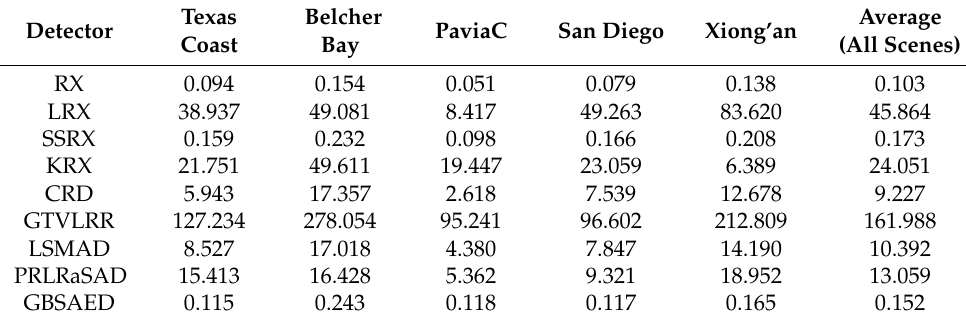
Table 3. Running times of each algorithm for five datasets.